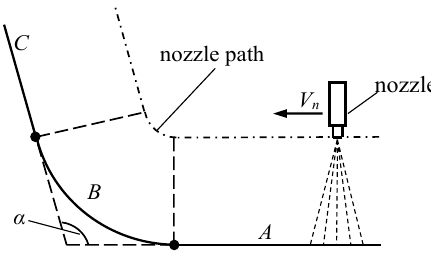
Figure 1. Sketch for painting arc connecting surface.